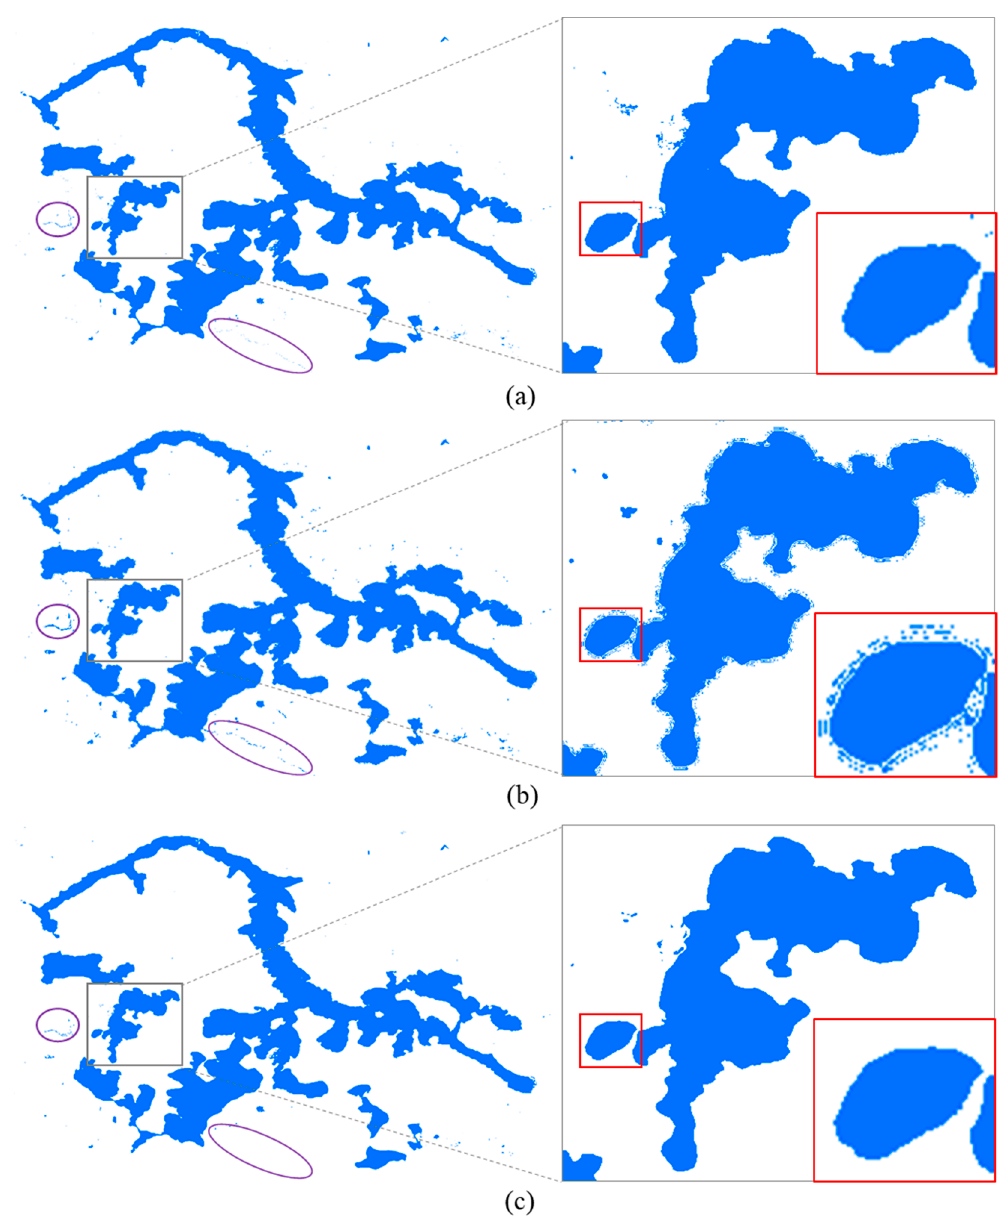
Figure 6. HR lake mapping obtained from two strategies with an upscale factor of 4. ( a ) ground-truth lake area, ( b ) lake area extracted by strategy 1, ( c ) lake area extracted by strategy 2.